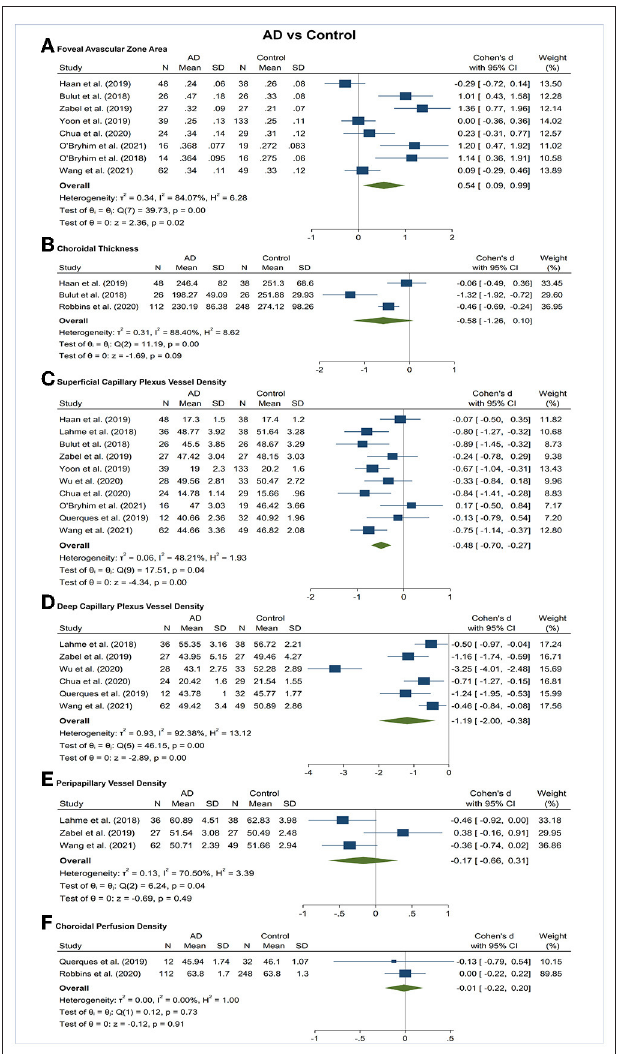
FIGURE 4 | Forest plot of OCTA measurements between subjects with mild cognitive impairment (MCI) and healthy controls. The meta-analyses were conducted with a random-effects model. Horizontal bar indicates 95% confidence intervals (CI), and the size of the squares denotes the weight attributed to each article. The diamonds represent the standardized mean differences with the width showing the 95% CI. (A) Foveal avascular zone area. (B) Choroidal thickness. (C) Superficial capillary plexus vessel density. (D) Deep capillary plexus vessel density. (E) Peripapillary vessel density. (F) Choroidal perfusion